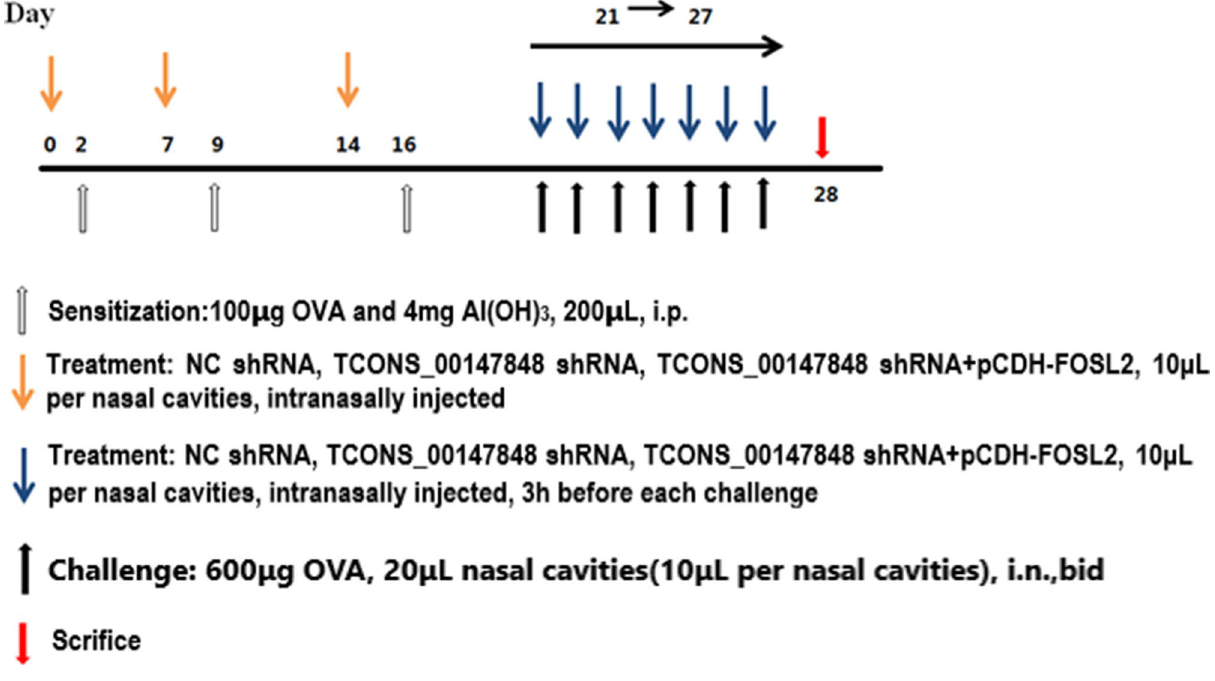
Figure 1. Schematic diagram of OVA-induced allergic rhinitis